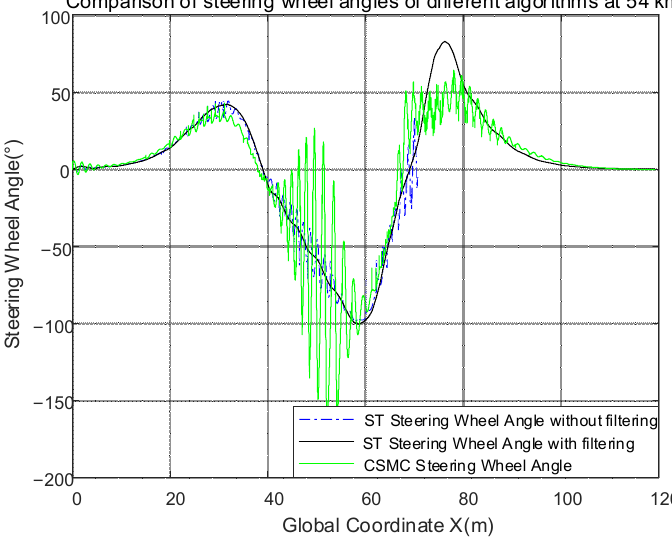
Figure 11. Comparison of steering wheel angles of different algorithms at 54 km/h.